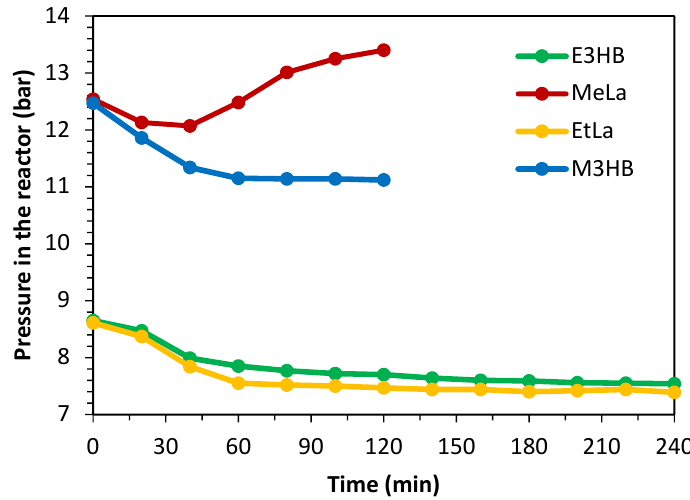
Figure 2. Pressure values dependence on time during depolymerization.